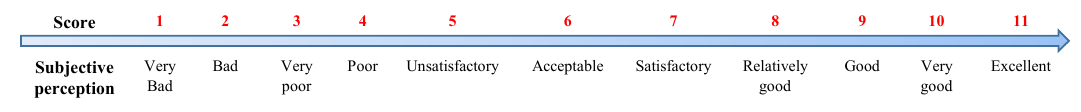
Figure 4. Subjective evaluation metric of the SQ.